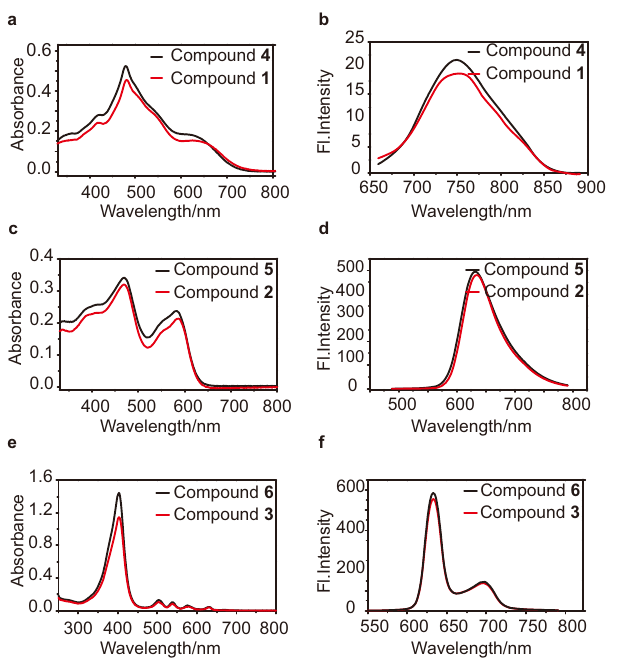
Fig. 2 Absorption spectra and emission spectra of compounds 1 – 6. Absorption spectra of ( a ) compound 1 and 4 , ( c ) 2 and 5 , ( e ) 3 and 6 . Emission spectra of ( b ) 1 and 4 ( λ ex = 640 nm), ( d ) 2 and 5 ( λ ex = 469 nm), ( f ) 3 and 6 ( λ ex = 403 nm) in ethanol. Fl fl uorescence.